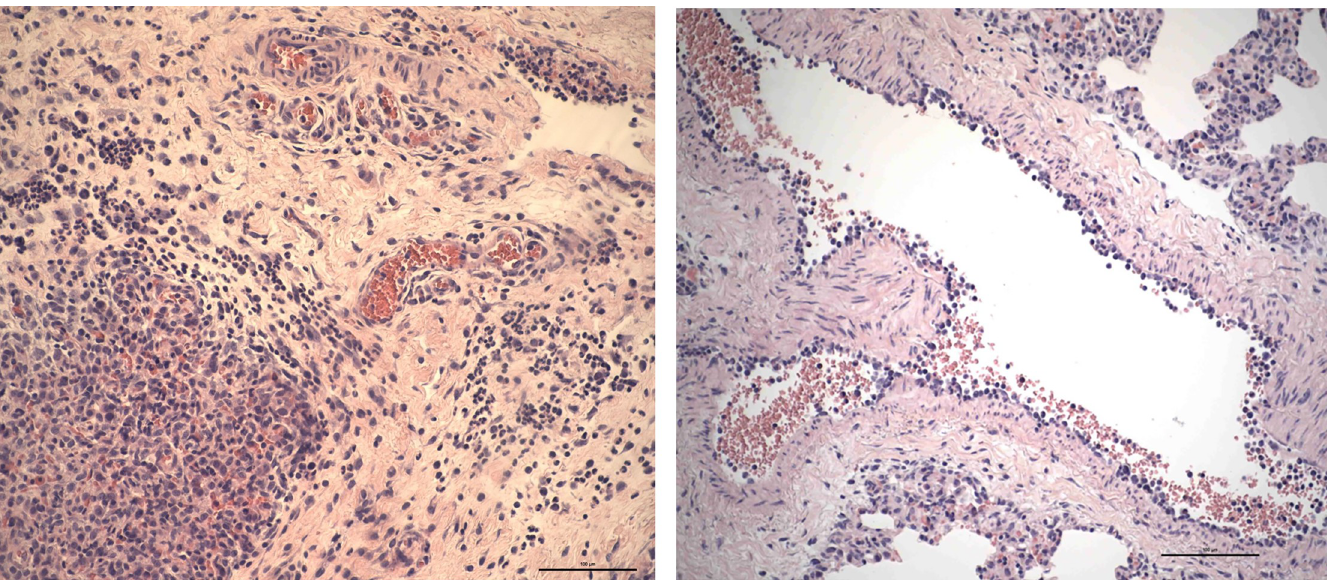
Fig 3. Histology of lung samples, AF-16 vs control. 3A Intense inflammatory cell reaction shows leukocytes rich in polymorphs in the alveoli (down, at left) and in the capillaries in the interlobular septum (AF-16). 3B Bronchial vessel shows leukocytes adhering at the endothelium. It could be an early stage in the process of leukocyte migration through the vessel wall, but leukocytes seem to remain in the intima which is suggestive of endoarteriolitis, which could be predisposing for thrombosis (control).